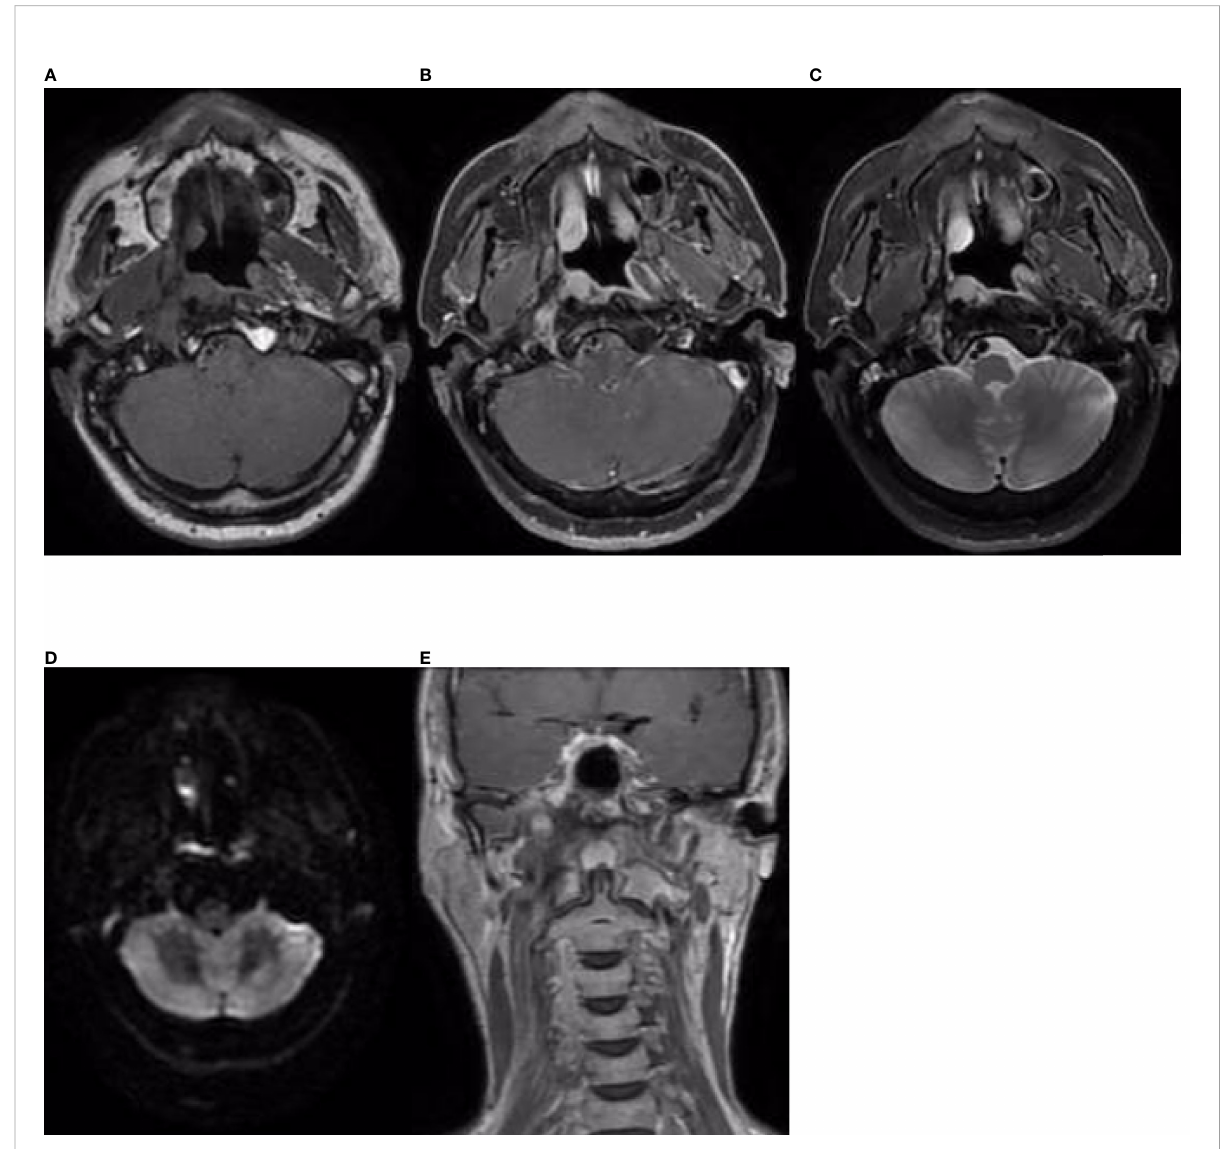
FIGURE 6 Nasopharynx and neck MRI fi ndings from 10 January 2022. (A – D) The axial planes of T1-weighted, enhanced T1-weighted, T2-weighted, and DWI and (E) the coronal plane of enhanced T1-weighted MRI, showing an area of enhancement in the right nasopharyngeal and parapharyngeal space. DWI demonstrated slightly restricted diffusion, which was considered indicative of